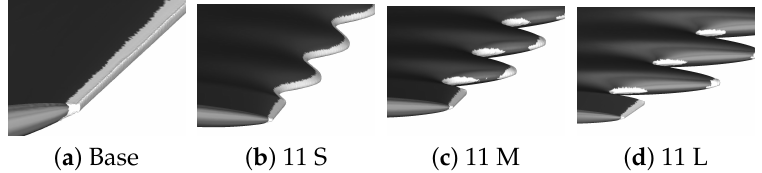
Figure 7. Changes in ice accumulation at the leading edge of different